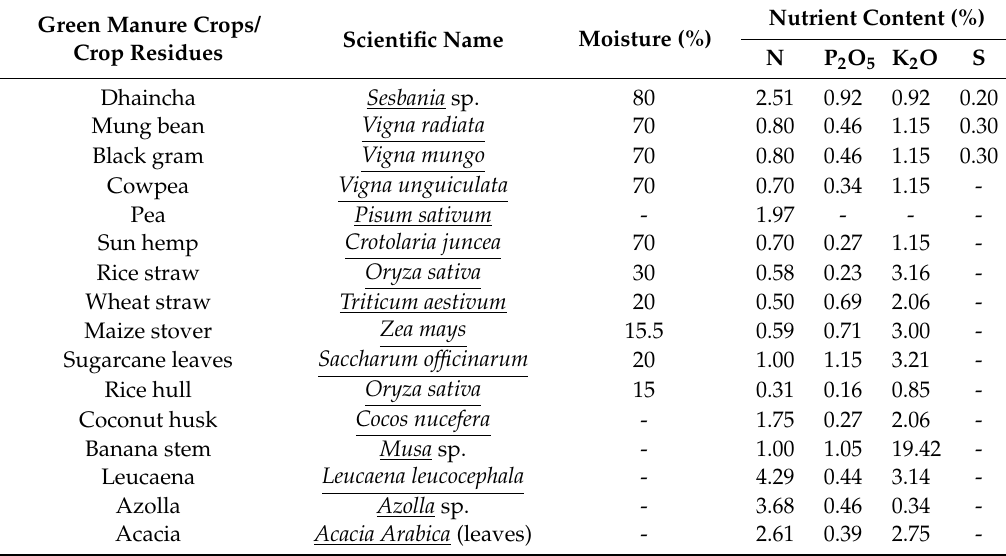
Table 2. Nutrient contents (%) of some commonly used green manure crops and crop residues in South and SE Asia (adapted from BARC, 2012 and Timsina, 2018, with permission from BARC, Bangladesh, 2012 and Agriculture & Forestry University, Nepal,